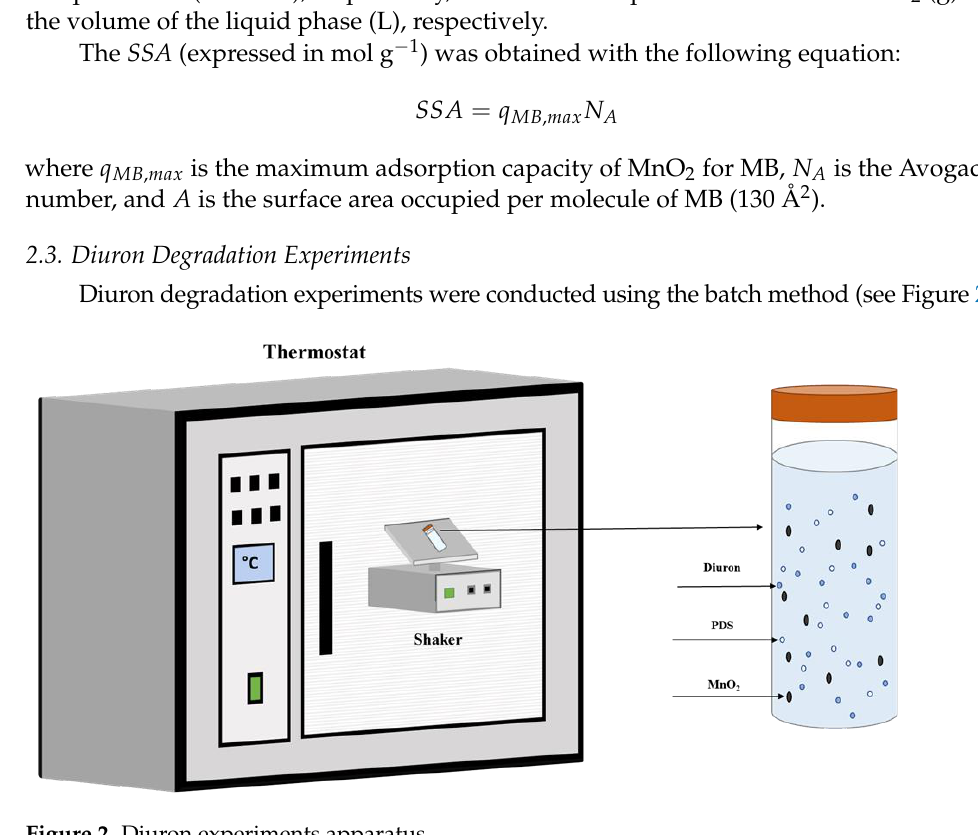
Figure 2. Diuron experiments apparatus.